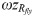
Experimental versus improved model responses in terms of pitch control dynamics.(A) Left panels give experimental (grey: individuals; dark: mean) and the simulated (color shaded: 10 individual samples; color plain: mean) pitch orientation versus time corresponding to the 3 groups of initiation time: 75-100ms are shown in green, 100-125ms in blue and 125-150ms in red. (B) Right panels represent the experimental (grey: individuals; dark: mean) and the simulated (shadowed: individuals; dark: mean) optic flows (ωzRfly: dotted lines, ωxRfly: solid lines) versus time corresponding to the 3 groups of initiation time: 75-100ms are shown in green, 100-125ms in blue and 125-150ms in red.